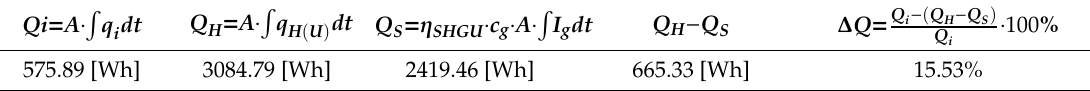
Table 5. Heat balance components calculated for January